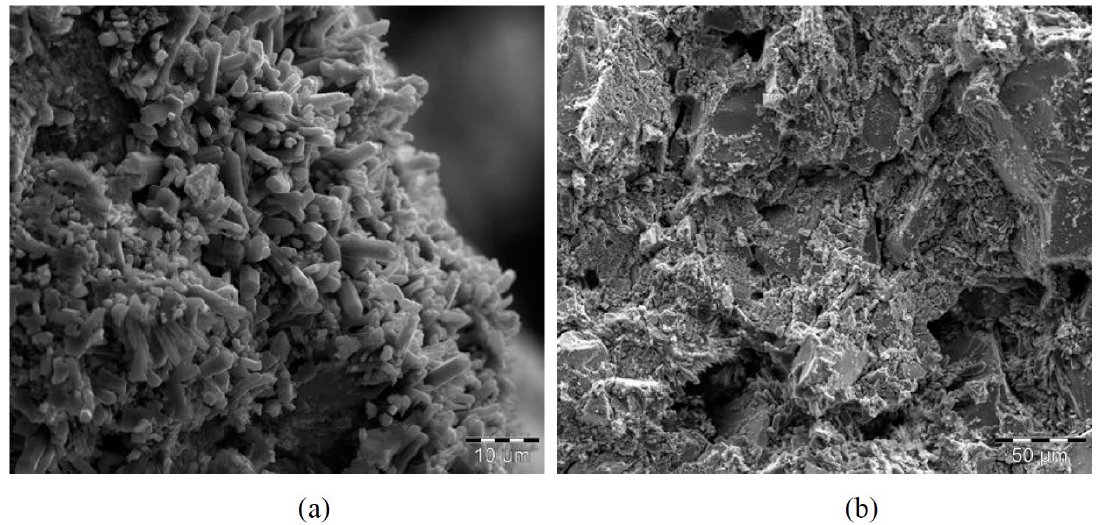
Figure 4. Backscatter SEM micrographs of the surface (a) and interior (b) of a 3 wt% sodium silicate bonded pellet dried for 32 days in a CO (g) 2